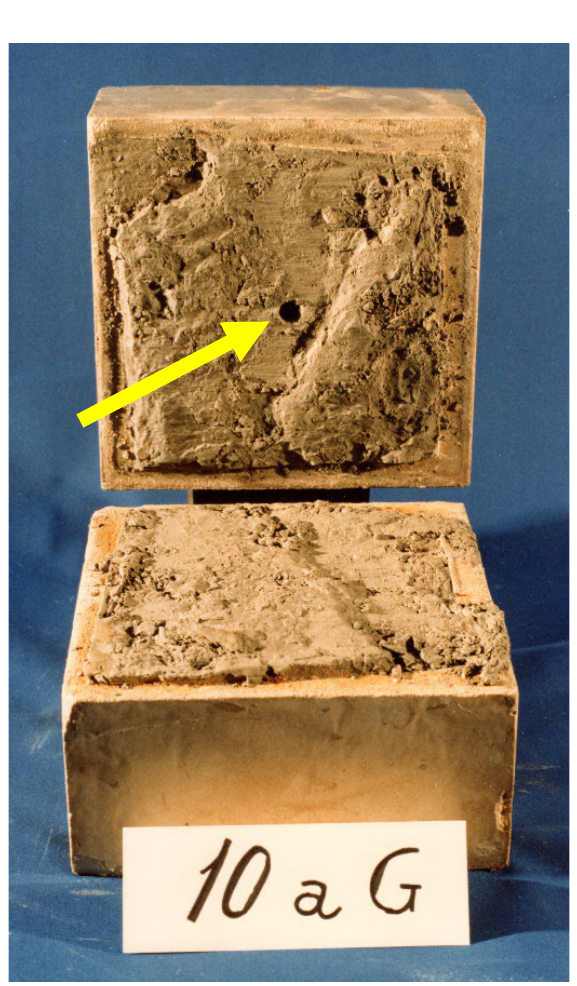
Figure 7 : Campolattaro marl specimen subjected to direct shear test (the arrow indicates the hole in the middle for the rock joint saturation) (after ISMES